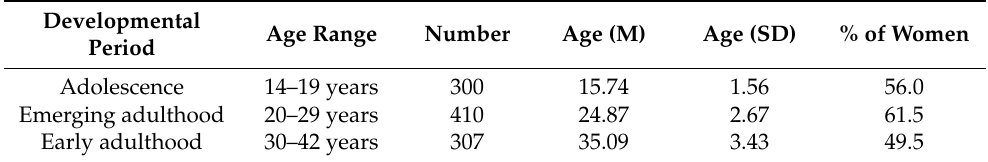
Table 1. Demographic characteristics of the